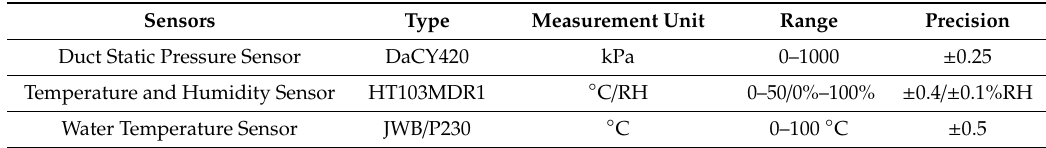
Table 1. Sensor parameters.